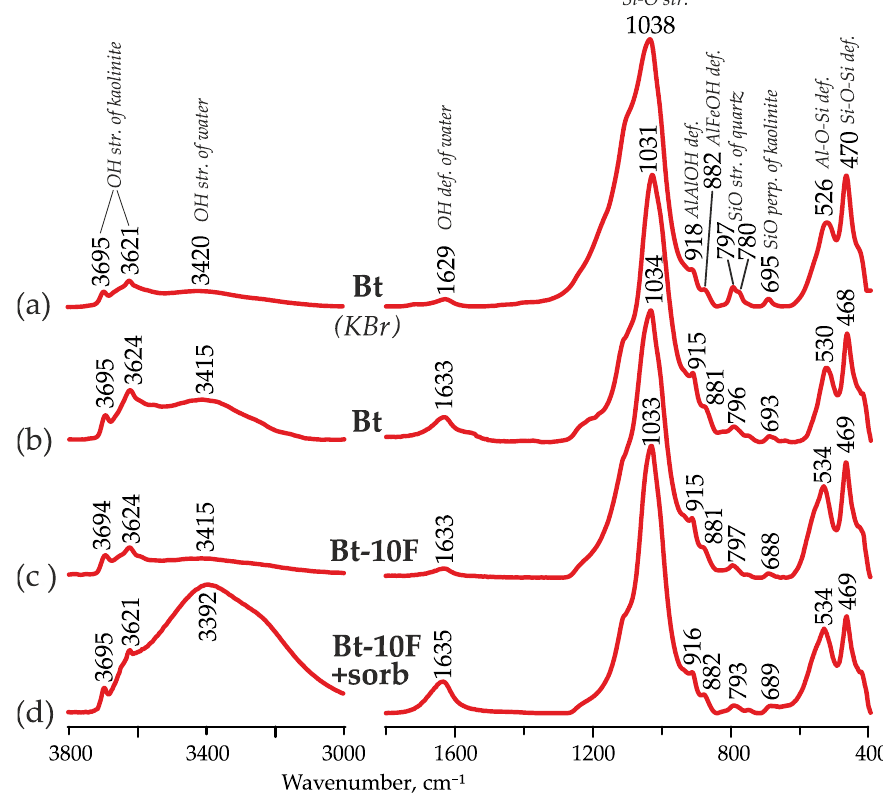
Figure 2. FTIR-spectra of investigated samples of bentonite ( a , b ), composite Bt-10F ( c ) and composite after adsorption of formaldehyde—Bt-10F + sorb ( d ).